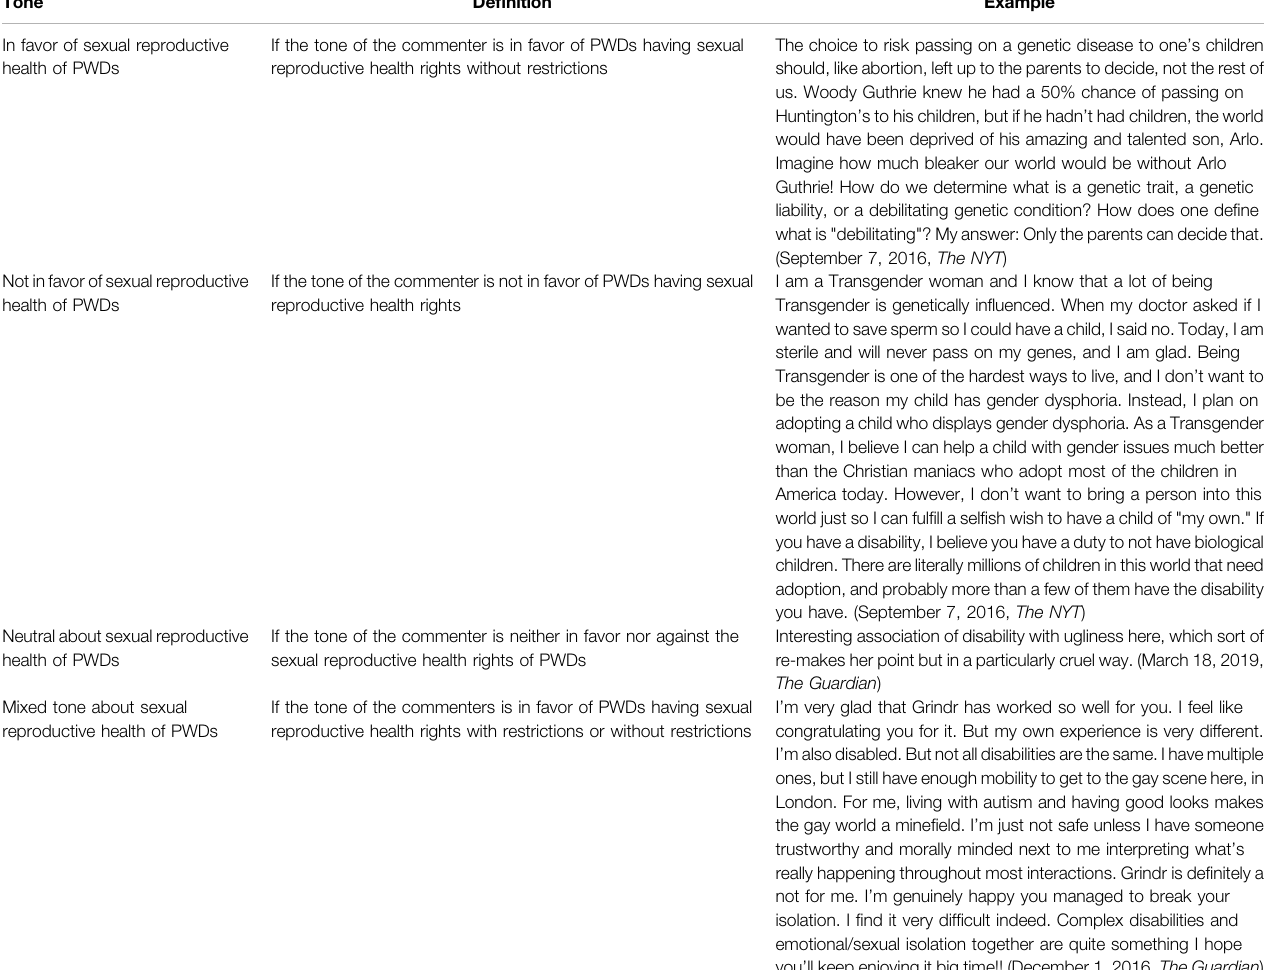
TABLE 2 | Tone of commenters regarding sexual reproductive health of PWDs in The NYT and The Guardian . Tone De fi nition Example In favor of sexual reproductive health of